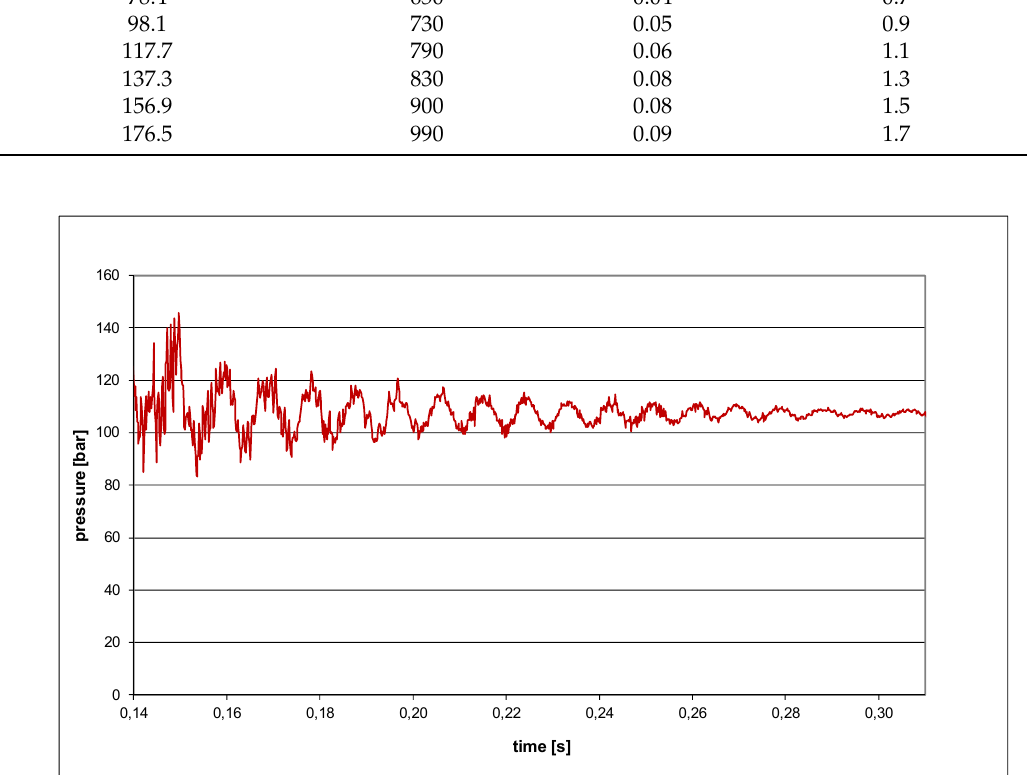
Energies 2021 , 14 , x FOR PEER REVIEW Figure 8. Opening of the safety valve. Figure 6. Opening of the safety valve. Table 2. Power occurring in the hydraulic leg during dynamic loading.